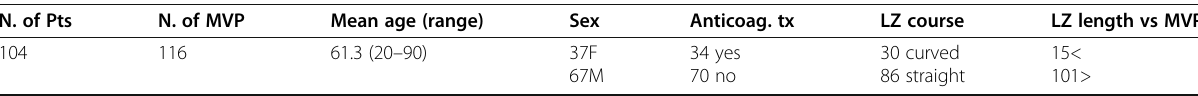
Table 1 Overall sample data N. of